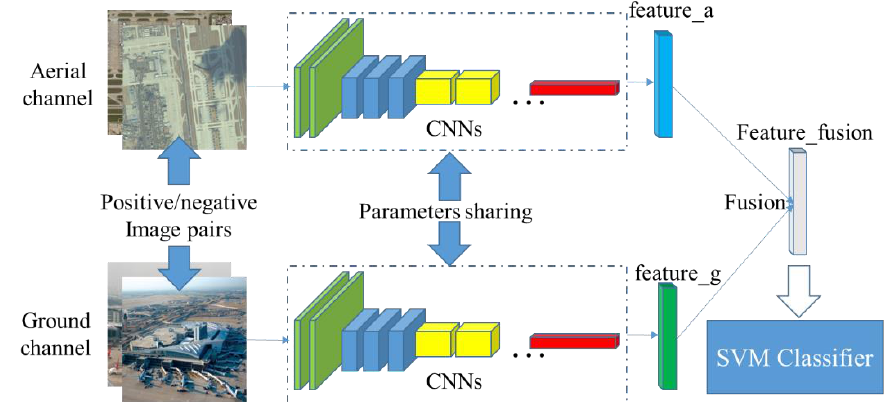
Figure 2. Architecture of the proposed cross-modal feature fusion.